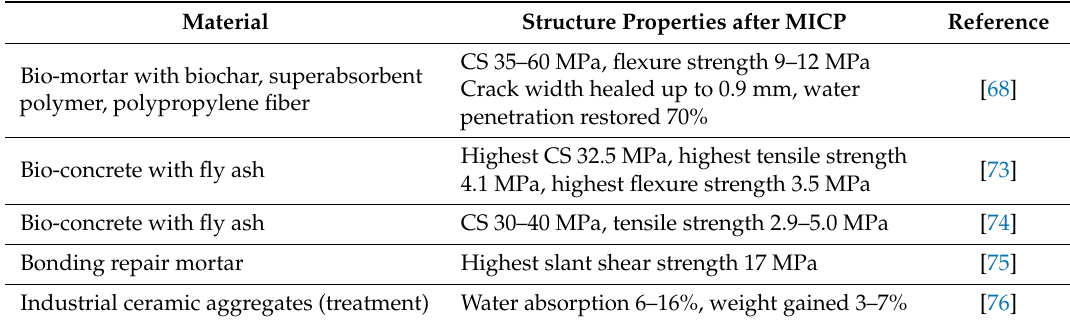
Table 3. Materials produced using MICP with Bacillus